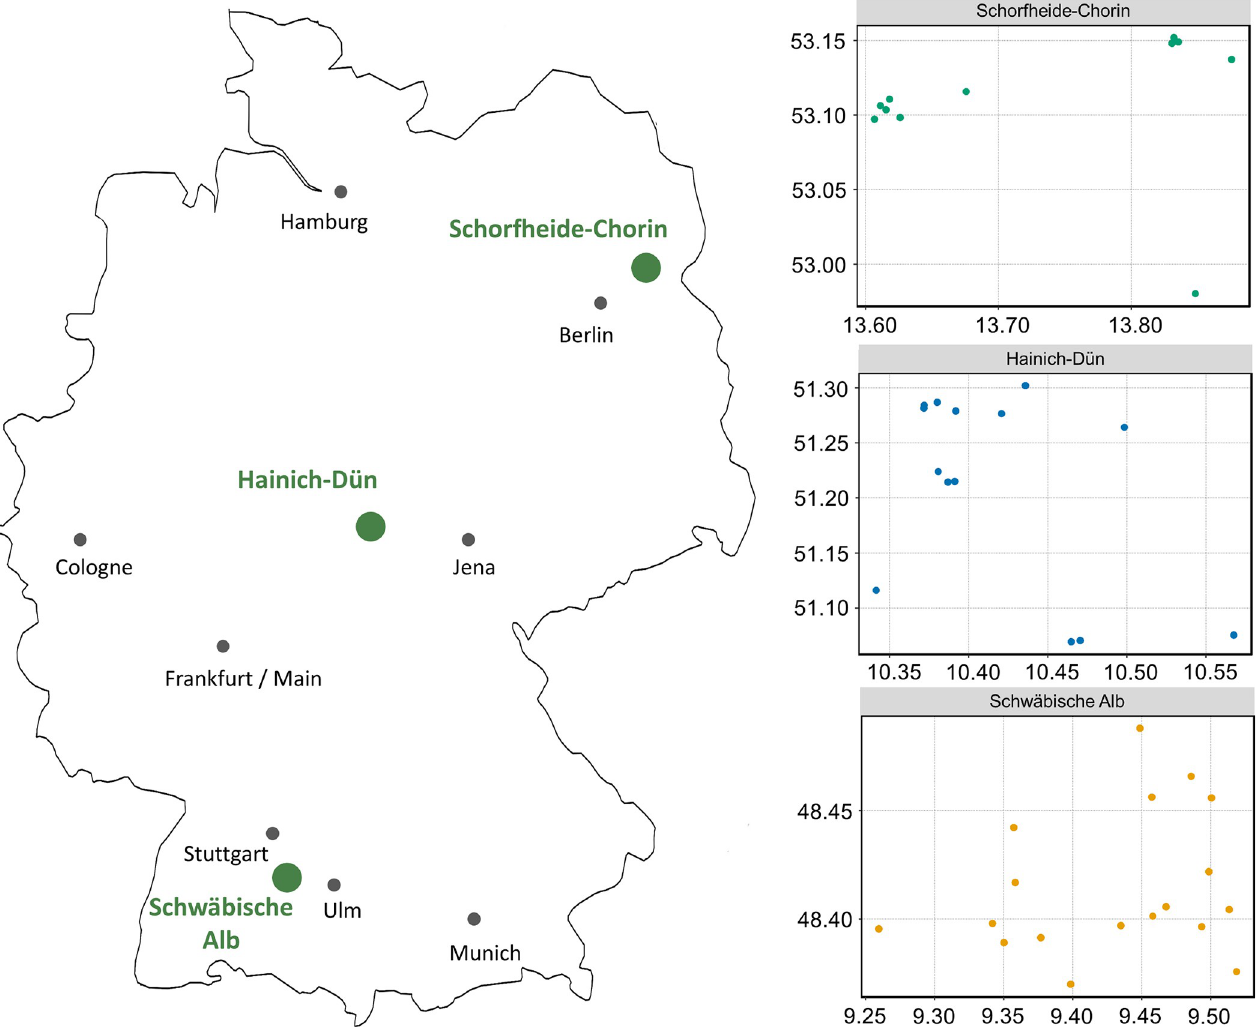
Fig 1. Map of all 42 experimental plots (EPs) in which B . lapidarius workers were sampled within the Biodiversity Exploratories Project and their location in Germany (Made with Natural Earth. Free vector and raster map data @ naturalearthdata.com). Each dot represents an individual EP.